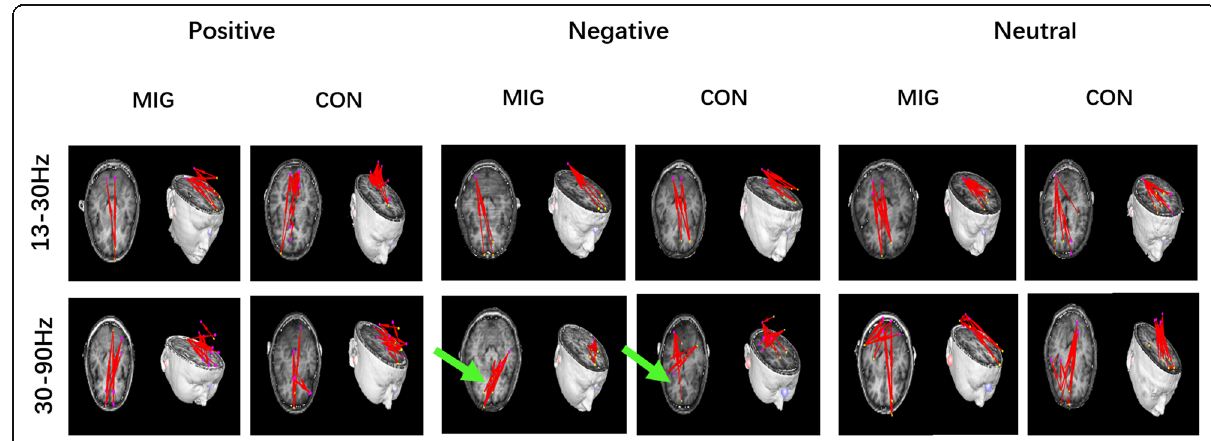
Fig. 4 Typical EC network patterns in the 13 – 90 Hz frequency range in migraine patients and controls in response to positive, negative, and neutral human expressions, respectively, visualized from the lateral (left column) and axial (right column) views. The migraine patients showed a significantly altered pattern of EC network at 30 – 90 Hz frequency range in viewing the negative emotional stimuli as compared to the controls, showing more connections from the prefrontal lobe to the temporal lobe, which are indicated by green arrows. No significant differences were observed between the two groups exposure to positive and neutral stimuli. (Colored figure